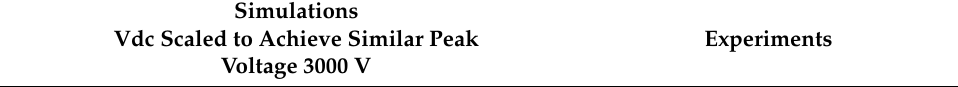
Table 9. Comparison of simulation and hardware results to check the effect of increase in voltage levels of MLI at same DC bus voltage.